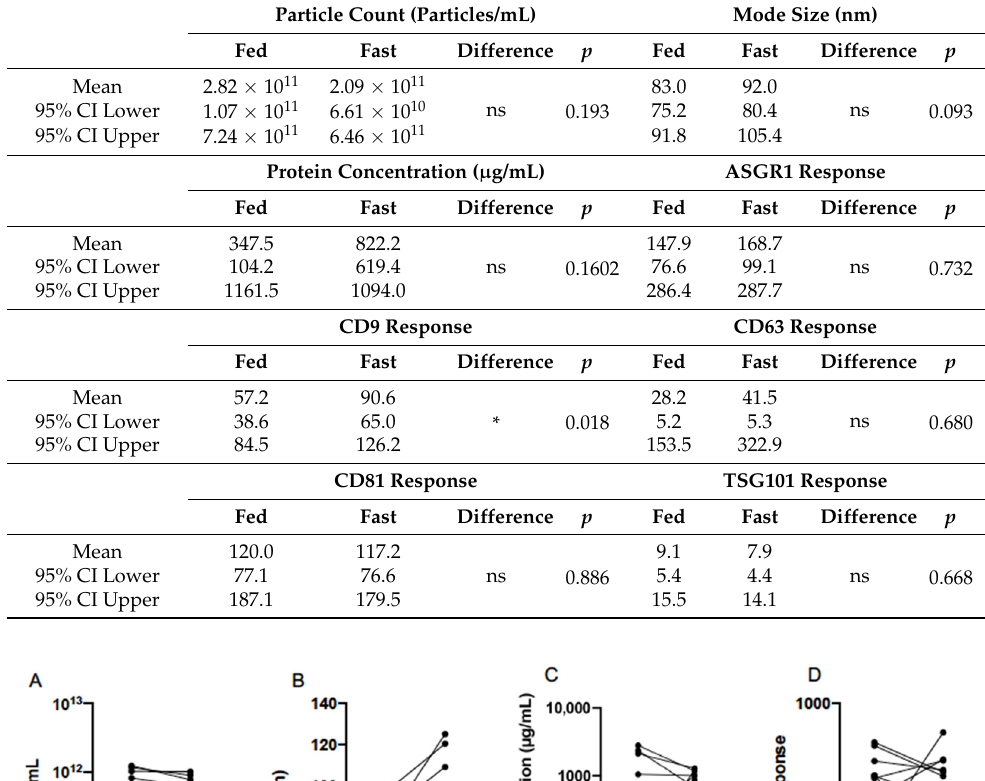
Table 3. Geometric mean and 95% confidence interval (CI) of particle count, mode size, total protein concentration, and EV-associated protein marker abundance quantified in EVs isolated from serum of healthy volunteers ( n = 10) in fed state and after an overnight fast. Statistical analysis performed using paired t -tests. ns: not significant; * p ≤ 0.05.